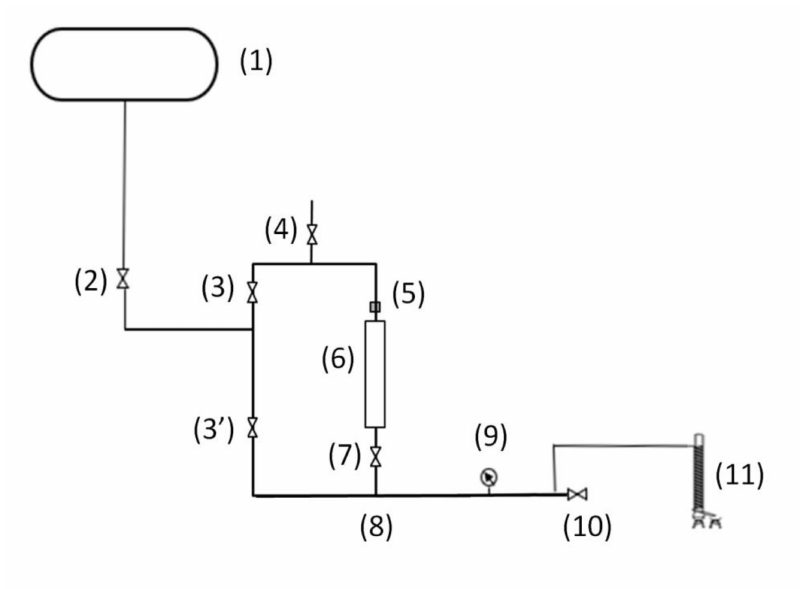
Figure 4. Hydraulic system scheme with: (1) olive oil tank; (2), (3), (3 (cid:48) ), (7), and (10) auxiliary sphere valves; (4) air purge valve; (5) removable coupling; (6) water injector pipe; (8) oil–water mixing zone; (9) digital manometer; (11) helical